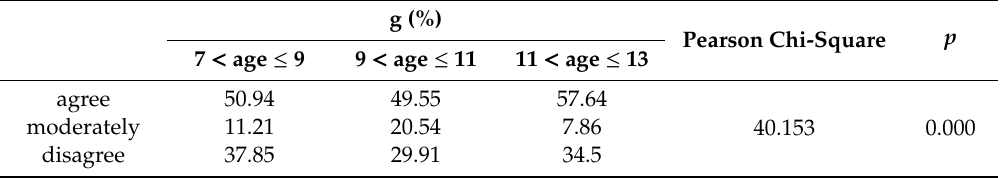
Table 4. The flexibility of di ff erent age stages children to use painting materials.